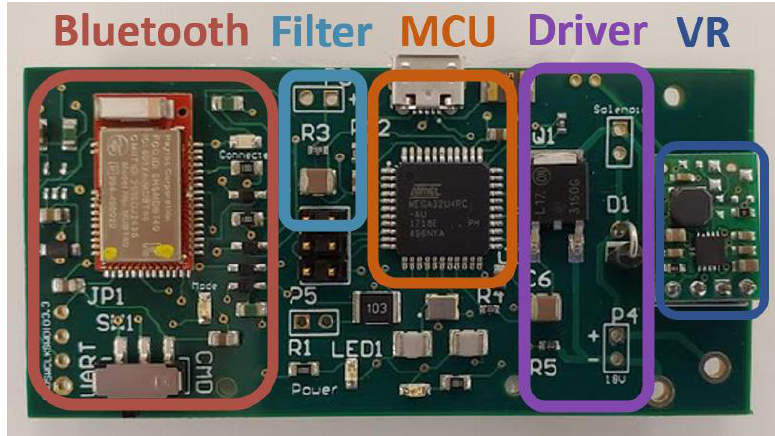
Figure 3. Photo of the final printed circuit board (PCB), which includes a Bluetooth transceiver, filter, microcontroller (MCU), transducer driver, and a voltage regulator (VR). The board is 76.2 mm wide and 36.8 mm high.